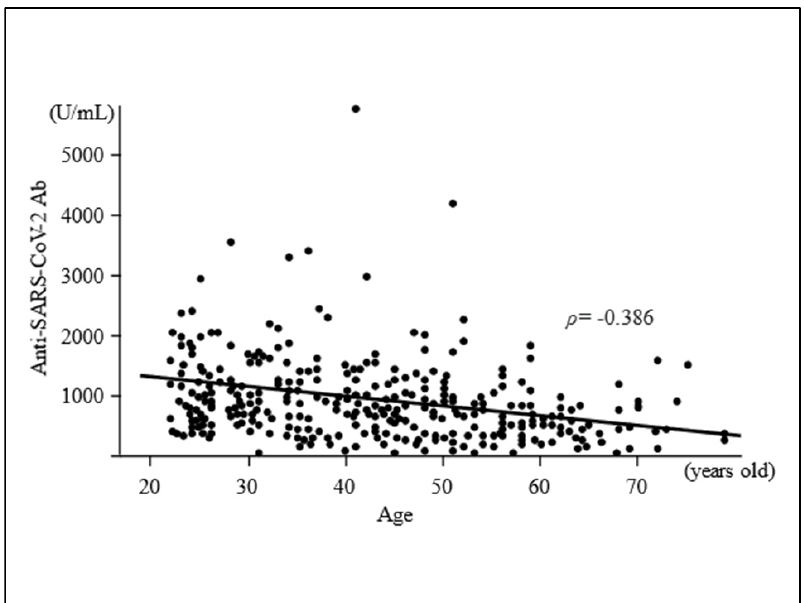
Figure 1. Scatter plot of the distribution of antibody titres according to age. Median antibody titre (IQR) against the SARS-CoV-2 spike antigen was 764 (423–1140) U/mL. Older participants had significantly lower SARS-CoV-2 antibody titres (correlation coefficient ρ = − 0.386).